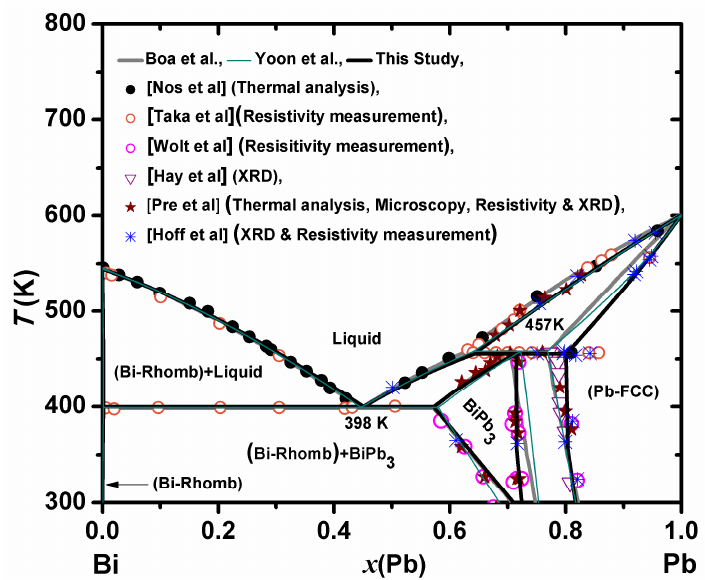
Figure 2. Calculated phase diagram of Bi-Pb system with experimental data (Wolt et al. [33], Predel et al. [34], Hoff et al. [35], Hay et al. [36], Nos et al. [39], Taka et al. [40]). Table 1. Comparison of invariants in Bi-Pb system between previous assessment and this study. Reaction Type T/K